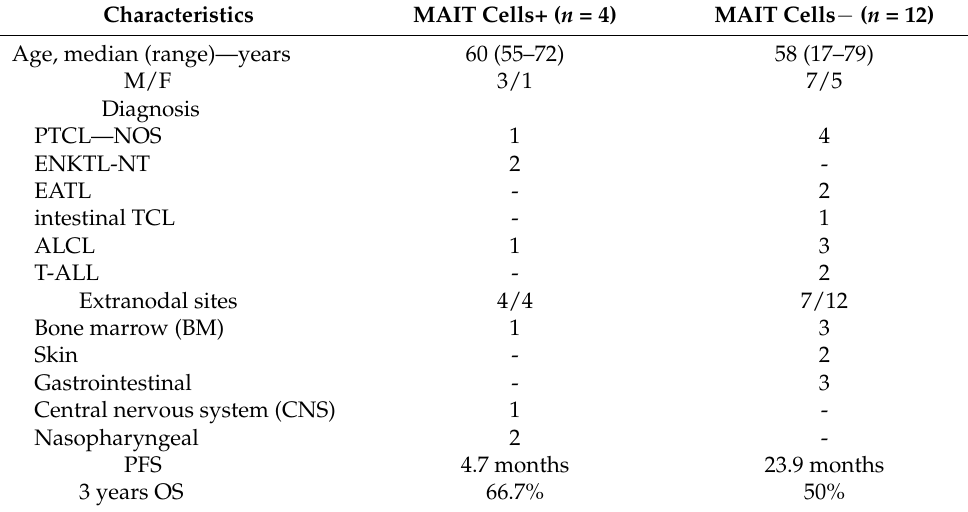
Table 3. Characteristics of patients included in this